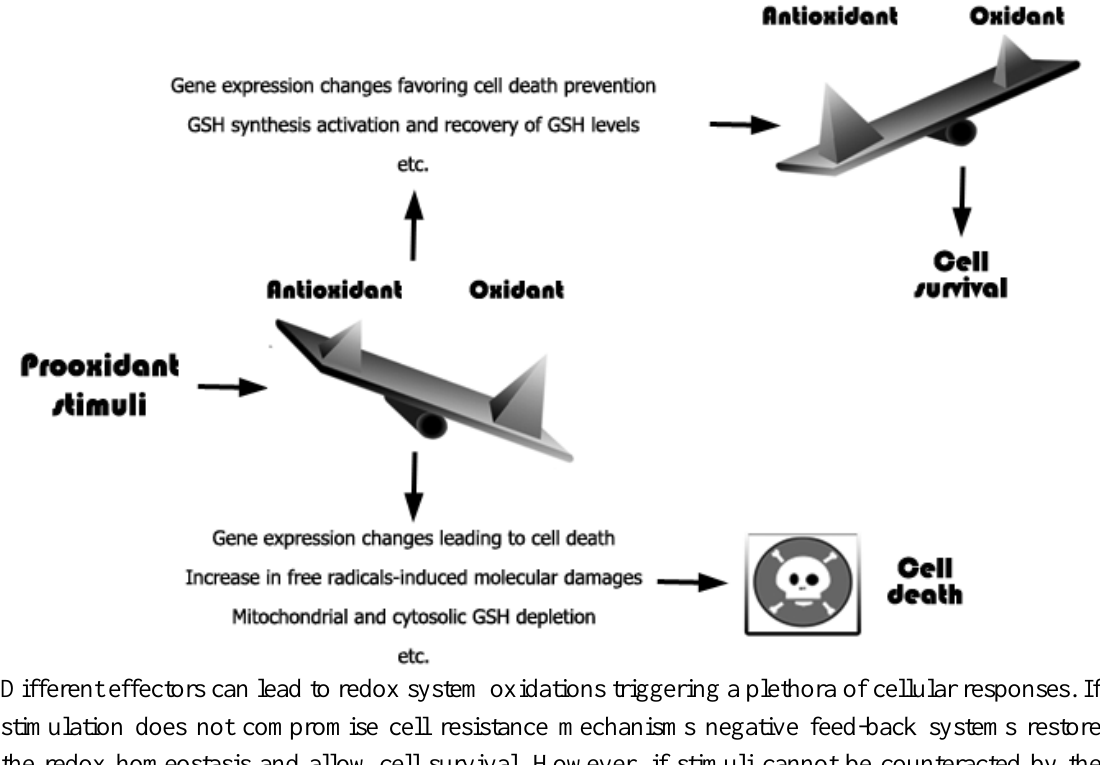
Figure 1. Cellular redox balance control regulatory pathways determining cell